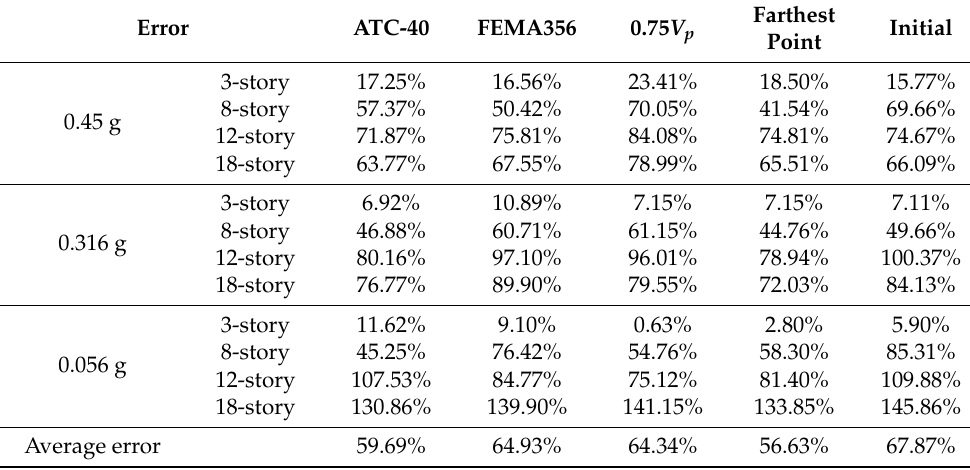
Table 6. Errors of calculated story accelerations (maximum value within all the